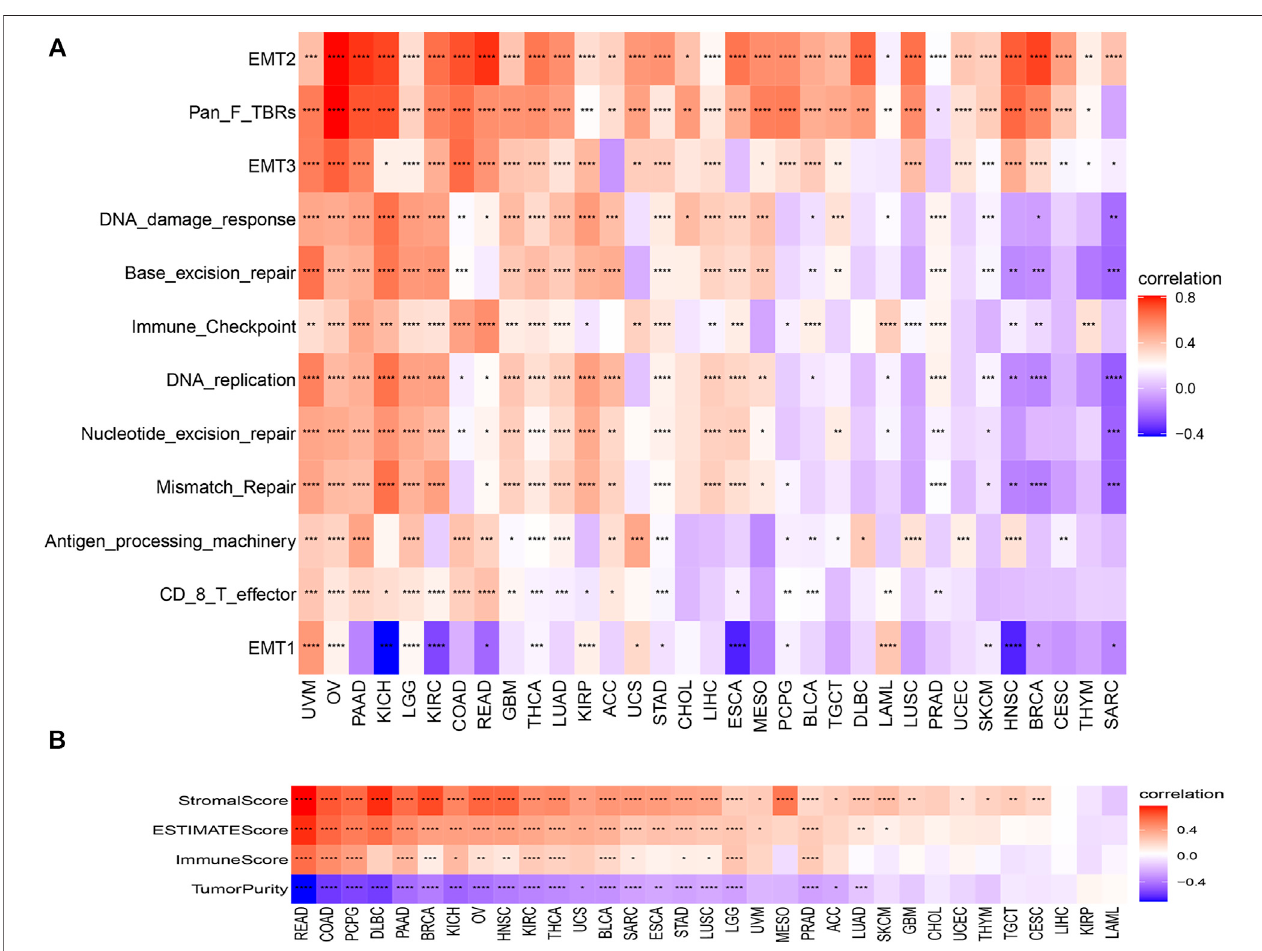
FIGURE 5 | Tumor microenvironment role of C1QTNF6. (A) The correlations between the C1QTNF6 expression level and TMEp scores. (B) the correlations between the C1QTNF6 express level and ImmuneScore, StromalScore, and ESTIMATEscore. * p < 0.05, ** p < 0.01, *** p < 0.001, **** p < 0.0001.